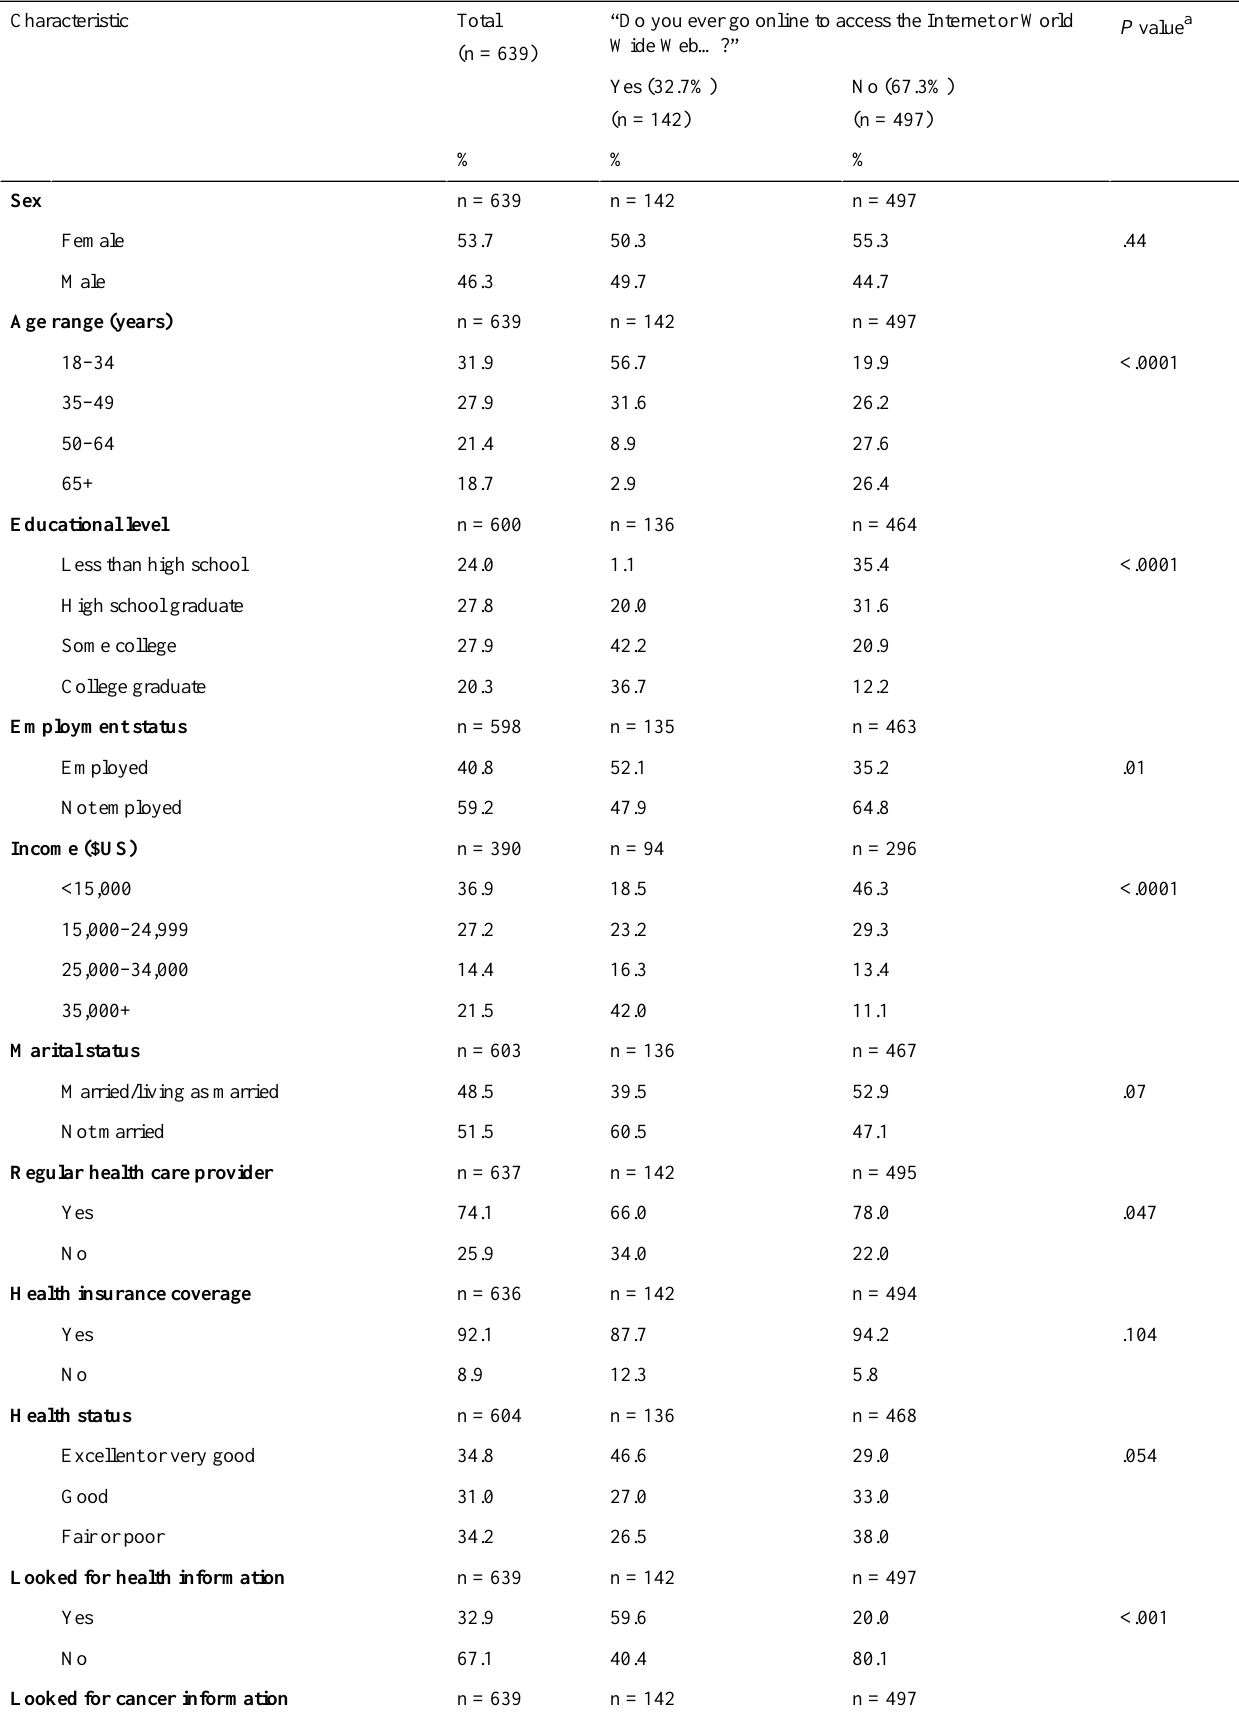
Table 1. Weighted estimates and sample frequencies for sociodemographic characteristics, health care access, and health information-seeking patterns of respondents who reported using the Internet and those who did